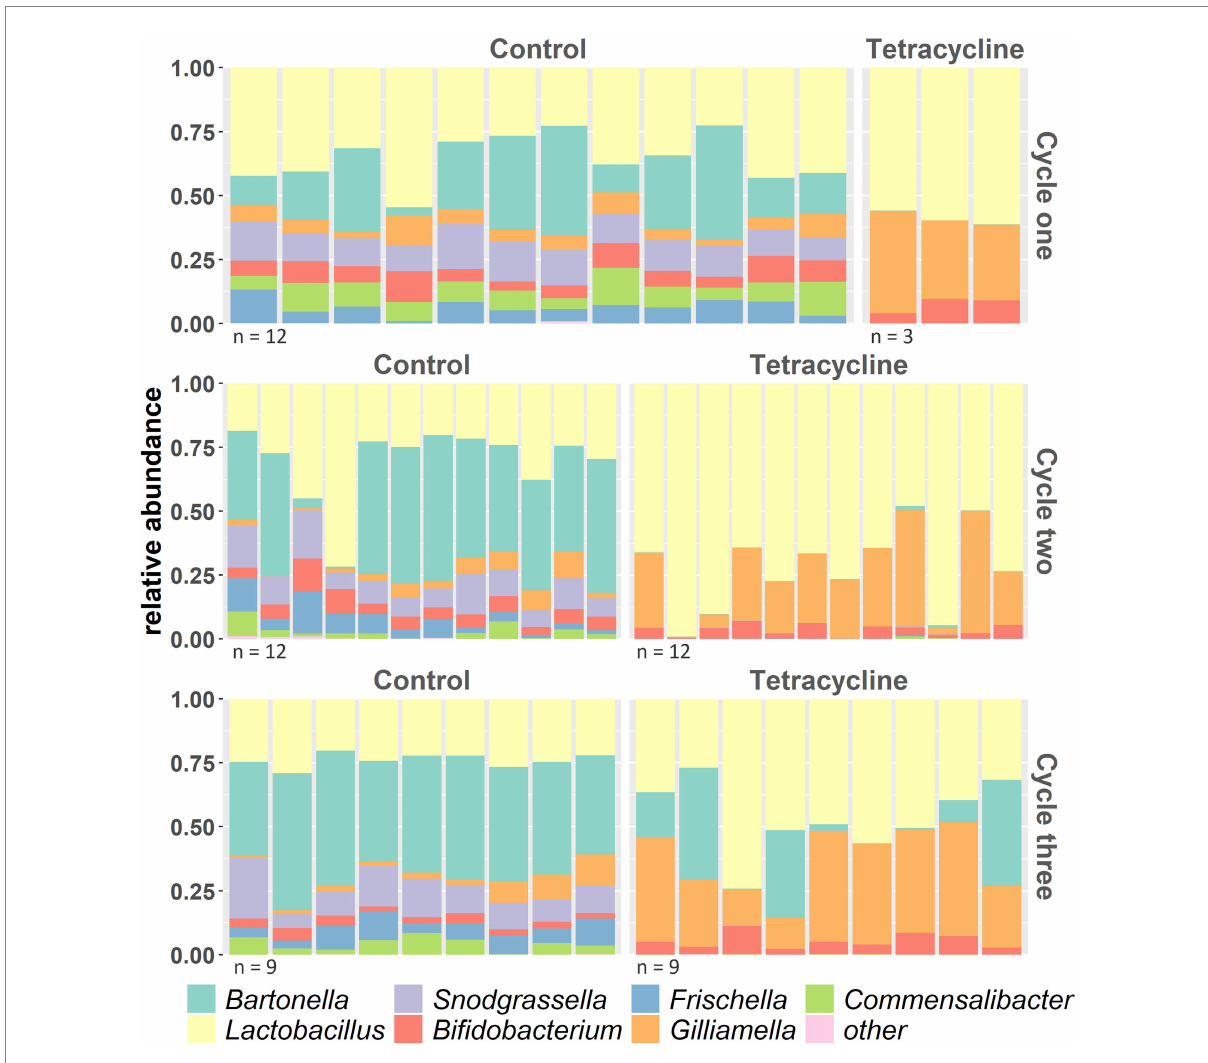
FIGURE 5 Taxonomy of bacterial genera across the 3 cycles (cycle three before high stress application) with at least 1% relative abundance across samples (everything else is combined to “others”) shows several taxa disappearing under